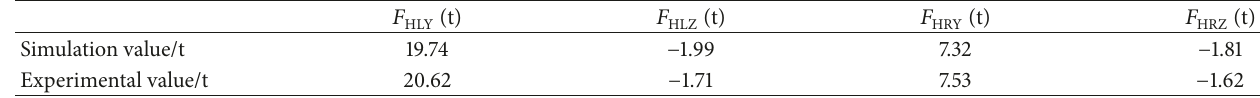
Table 8: Comparison of forces acting on plane support plate pin shafts.